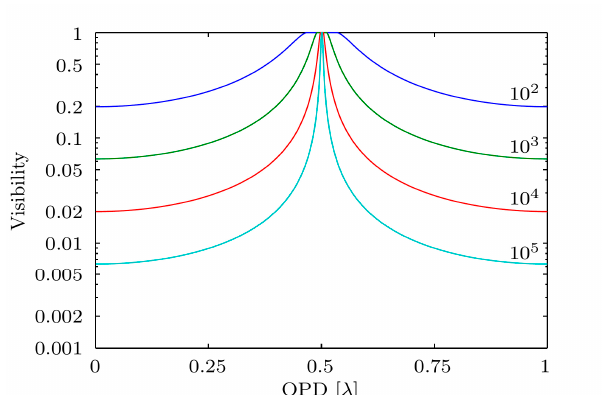
Figure 3. Fringe visibility is displayed vs OPD with the intensity ratio as a parameter. The resulting visibility is 1 when the difference of the optical paths in the interferogram arms is equal to one half of the wavelength. The visibility drops to 6.3 × 10 − 3 when the optical path difference within the interferometer is a multiple of the wavelength, for the intensity ratio of 10 5 .